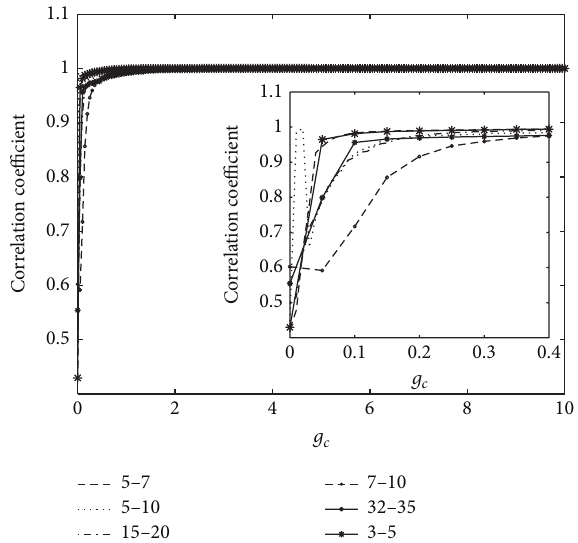
Figure 6: Correlation coefficient with respect to the coupling strength 𝑔 𝑐 of all the